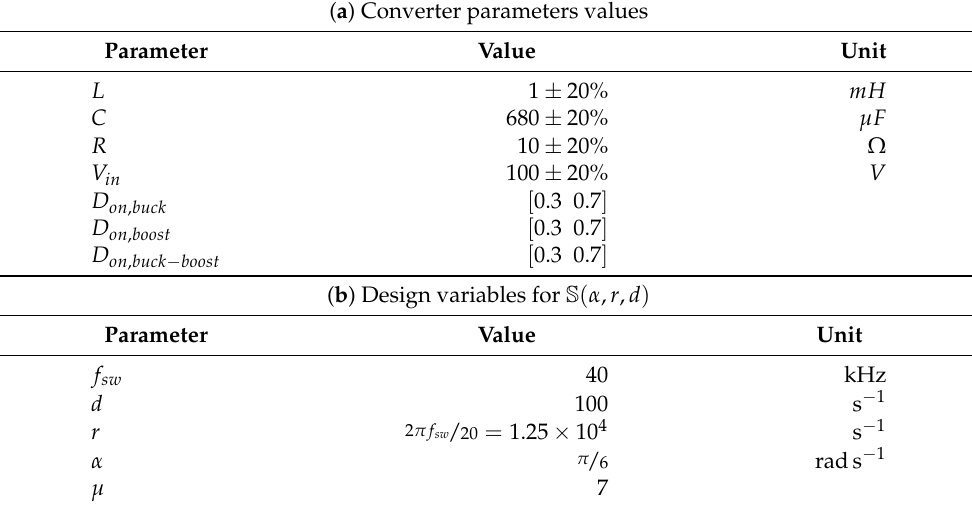
Table 1. Numerical values: Photovoltaic approach. ( a ) Converter parameters values Parameter Value Unit L 1 ± 20%